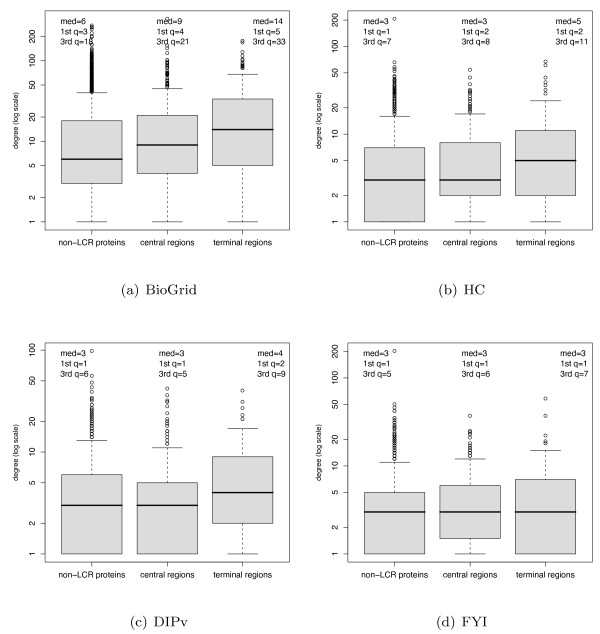
Degree distribution comparisons. Boxplot representations comparing degree distributions of t-LCRs, c-LCRs, and proteins without LCRs. Table 4 shows Wilcoxon-Mann-Whitney p-values resulting from comparing their degree distributions.